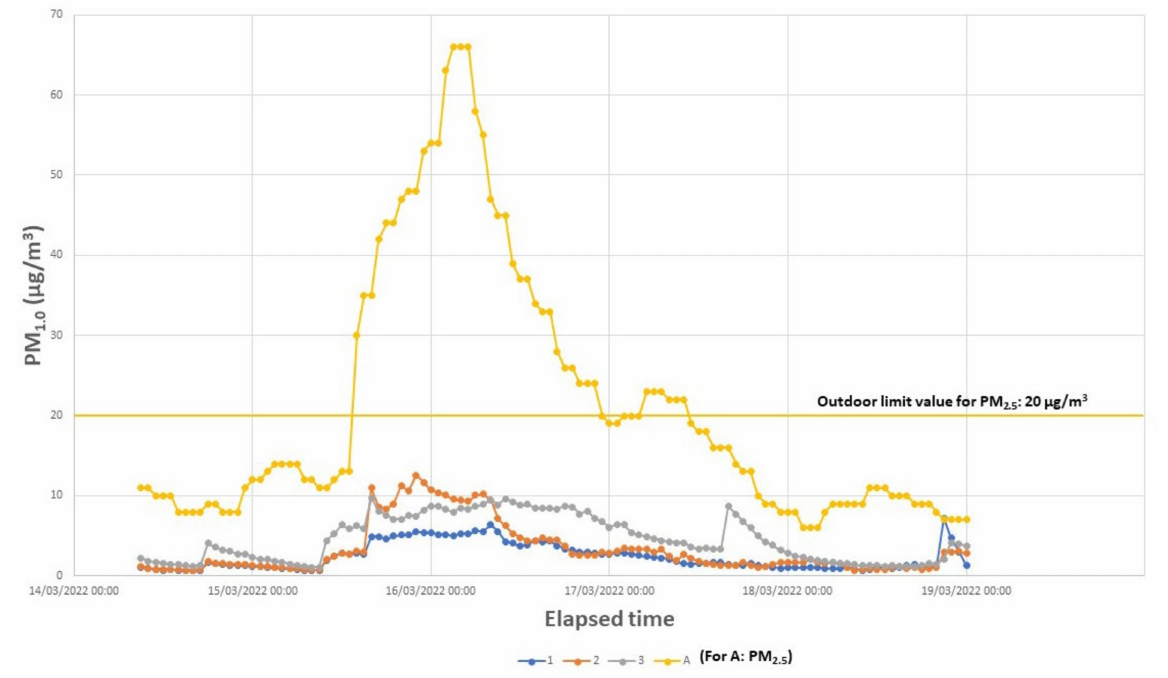
Figure 7. Recorded indoor PM 1 concentrations in buildings 1, 2, and 3, and station A (PM 2.5 , outdoor) from 14 to 19 March 2022. Outdoor limit value according to European legislation [15].